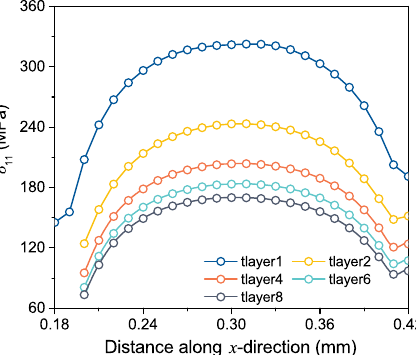
Figure 12. The position along the center line of the printing direction, and the σ 11 distribution of the top layer after the printing of each